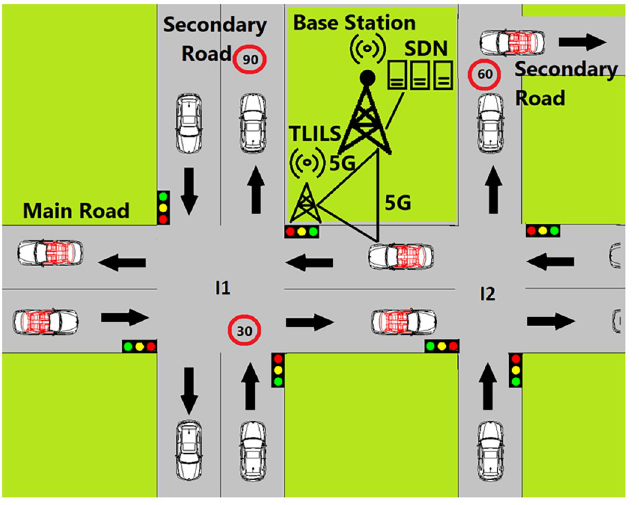
Fig 2. Optimized 5G traffic-based location server placement.